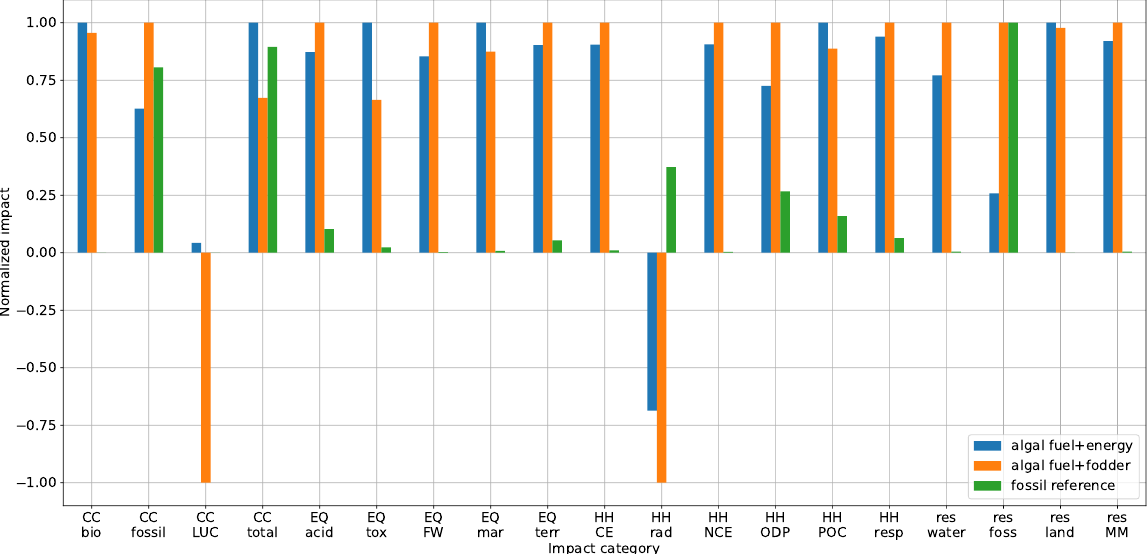
Figure 2. Comparison of environmental impacts: AF + energy (blue), AF + fodder (orange), and petroleum diesel (green). Note that the bars are normalized by the maximum in each category. Abbreviations: CC—climate change; EQ—ecosystem quality; HH—human health; res—resource depletion; bio—biogenic; LUC—land use and land use change; acid—freshwater and terrestrial acidification; tox—freshwater ecotoxicity; FW—freshwater eutrophication; mar—marine eutrophication; terr— terrestrial eutrophication; CE—carcinogenic effects; rad—ionizing radiation; NCE—non-carcinogenic effects; ODP—ozone depletion potential; POC—photochemical ozone creation; resp—respiratory effects; water—water dissipation; foss—fossil; land—land use; MM—minerals and